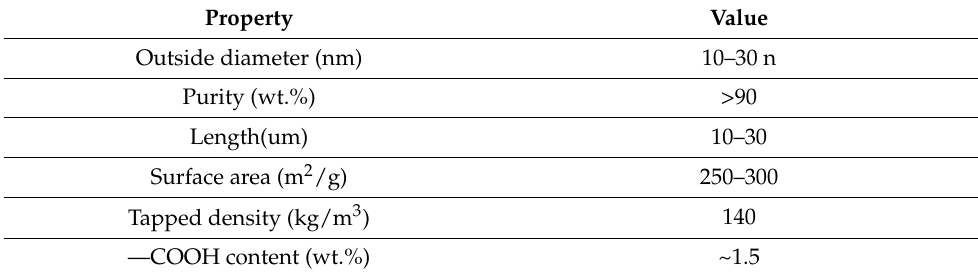
Table 2. Physical and chemical properties of functionalized MWCNTs.